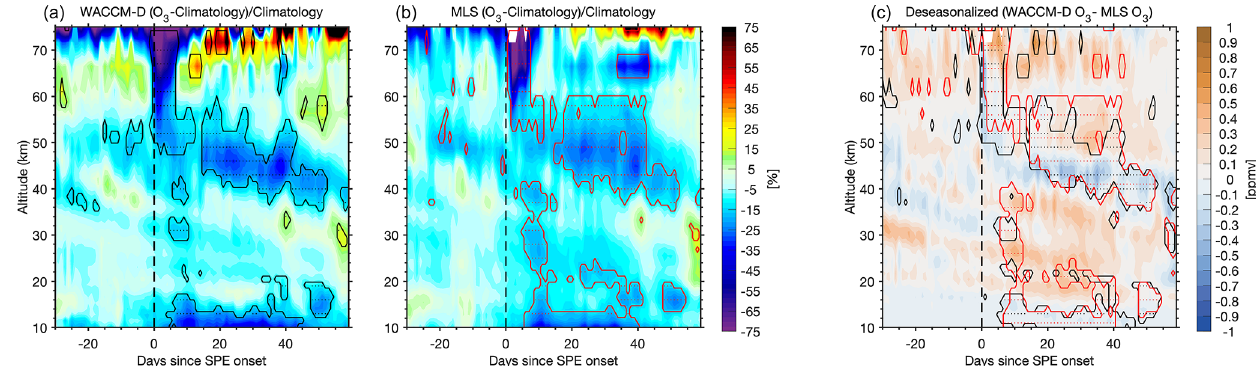
Figure 5. WACCM-D (a) and MLS (b) relative ozone anomalies along with altitude at 30d before and 60d after SPE on 16 January 2005. The WACCM-D simulations used here are the profiles at MLS measurement time and locations. The climatology was calculated using data between July 2004 and December 2012 for both MLS and WACCM-D. The black and red thick line area demonstrates the relative ozone anomalies with > 95% confidence after the Monte Carlo test. Panel (c) shows ozone differences between WACCM-D and MLS during this time frame (deseasonalized means that the seasonal differences shown in Fig. S4 were removed). The black and red thick line area demonstrates direct ozone anomalies with > 95% confidence after the Monte Carlo test from WACCM-D and MLS data,